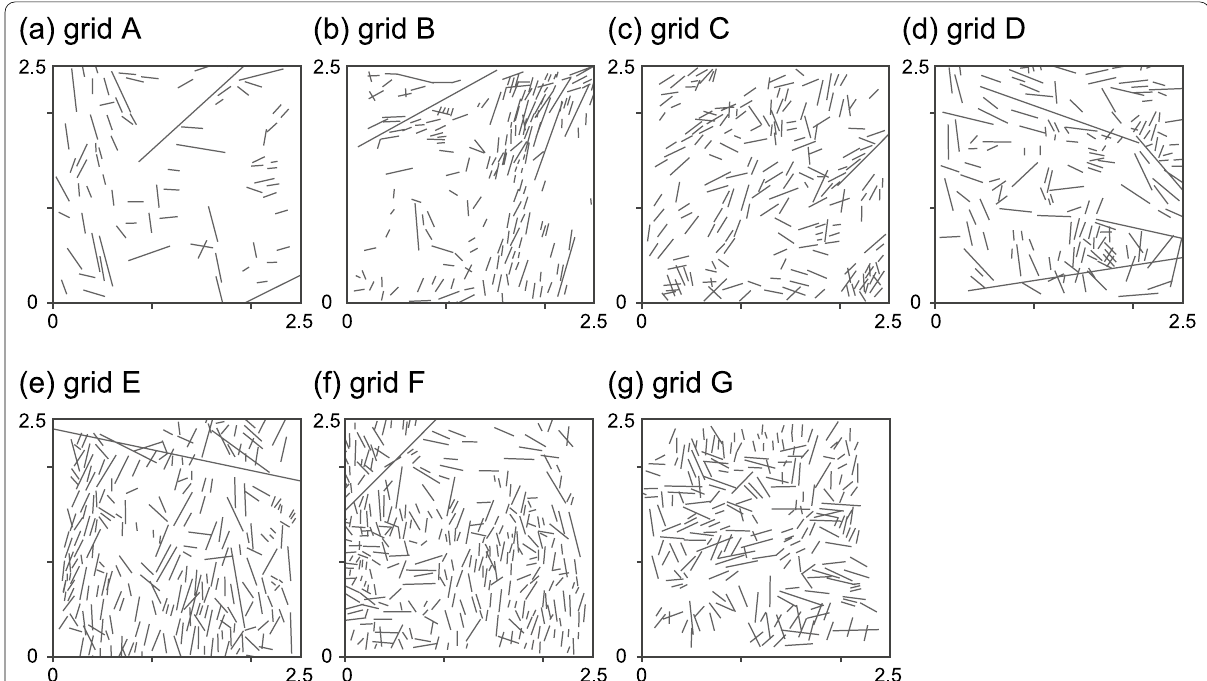
Fig. 7 a – g Trace maps of veins in grids A to G. The sides of each grid are approximately 2.5 m long. Horizontal and vertical axes represent easting and northing, respectively